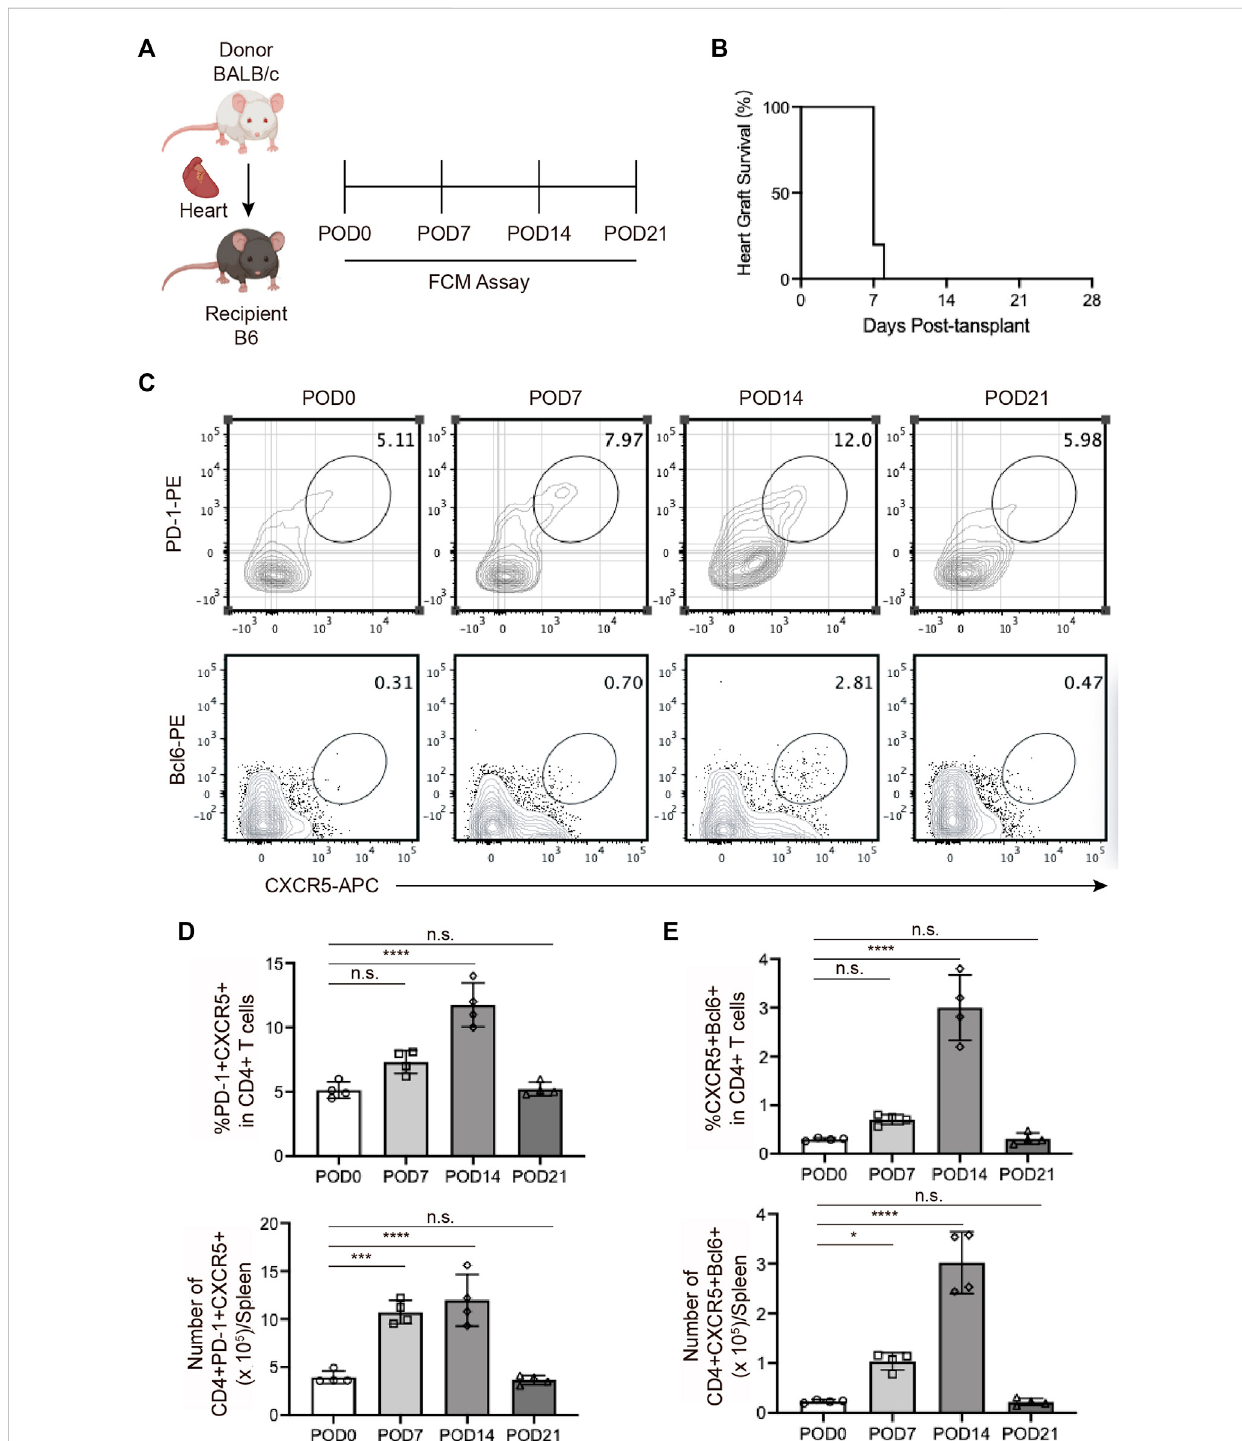
FIGURE 1 The expansion of T follicular helper cells during acute cardiac transplant rejection in mice (A) . Illustration of the experimental design in (B – E) . The murineintra-abdominalheterotopiccardiactransplantationmodel(BALB/ctoB6mice)wasestablished,andthespleensofrecipientmicewerecollected for fl owdetection at0,7,14,and 21 dayspost-transplantation (B) .The survival statusofthegraftswasobservedevery daythroughpalpation.Thesurvival time is illustrated in the survival curves (C) . FCM analysis of the proportions of PD1+CXCR5+ Tfh and BCL6+CXCR5+ Tfh in the spleens of recipient mice at 0, 7, 14, and 21 days post-transplantation (D) . The bar charts ( n = 4) show the ratios and numbers of PD1+CXCR5+ Tfh cells in the spleens at differenttime points, as described in1a (E) . The bar charts ( n = 4) show theratios and numbers of BCL6+CXCR5+ Tfh cells inthespleens atdifferenttime points, as described in 1a.Error bars represent SD. ns, not signi fi cant, * p < 0.05, ** p < 0.01, *** p < 0.001, **** p <